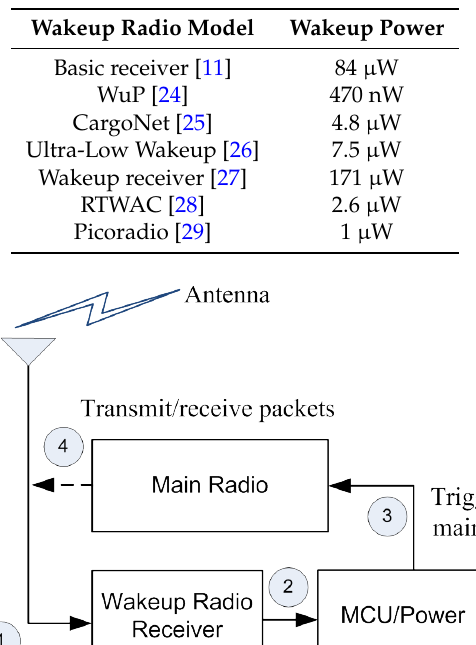
Table 1. Wake up radio and power consumption.